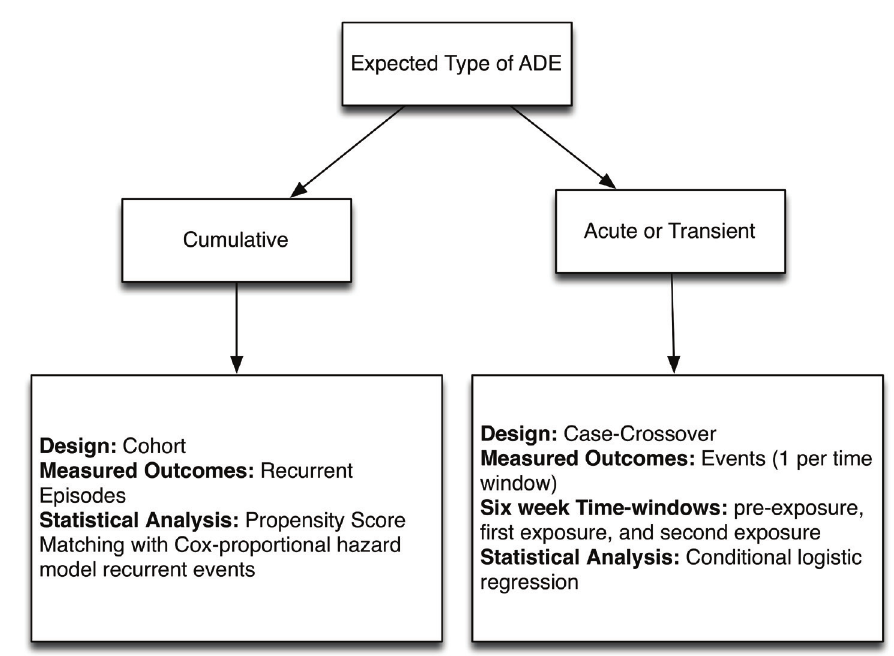
Figure 2. Study designs used for adverse event discovery and their